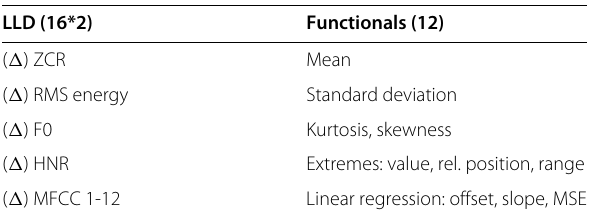
Table 2 Features in the INTERSPEECH 2009 emotion challenge feature set